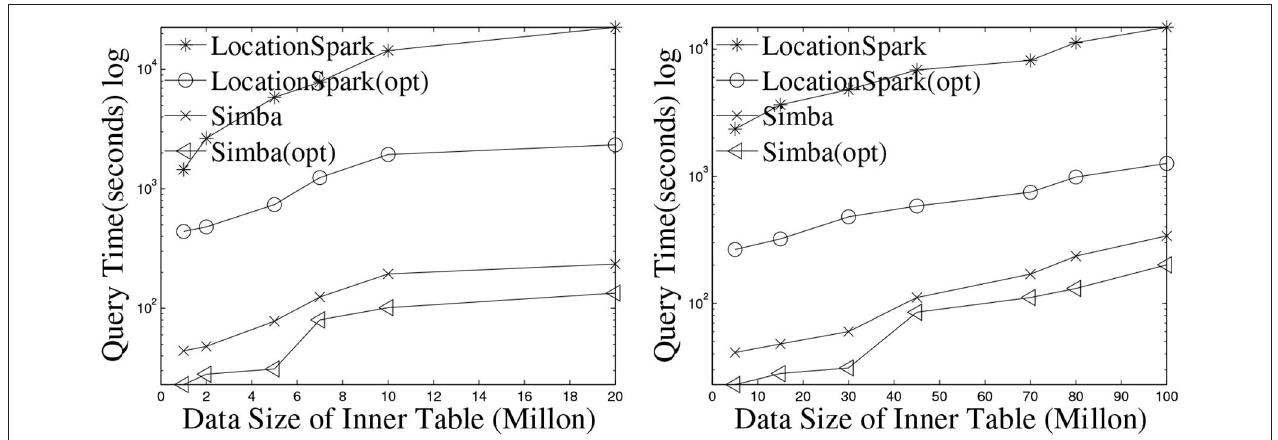
FIGURE 6 | Performance of k NN join by increasing the number of data points for OSMP (left) and Twitter (right) .